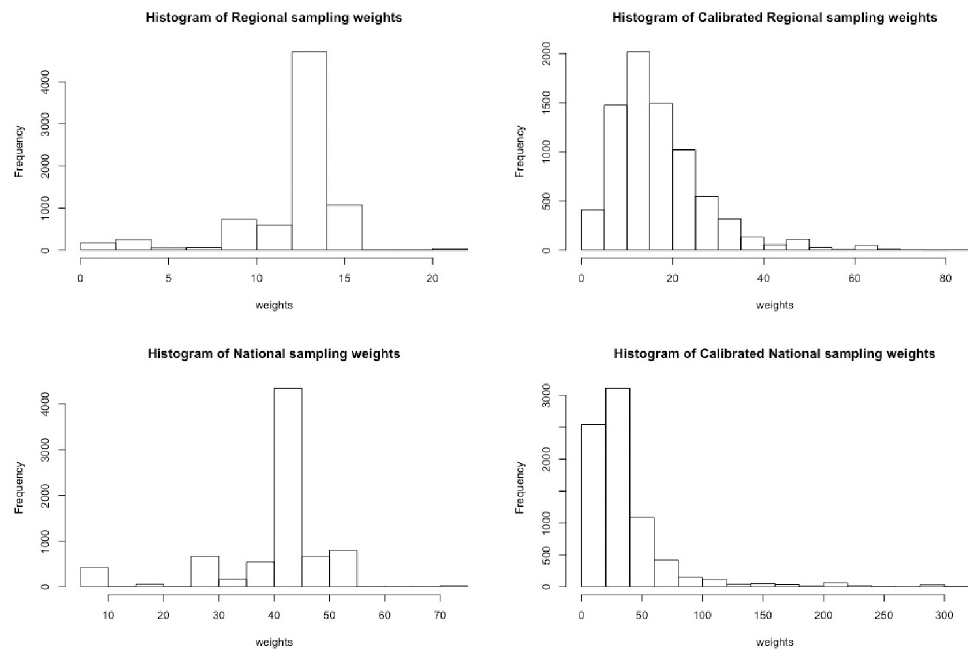
Fig 2. Distribution of regional and national sampling weights and calibrated